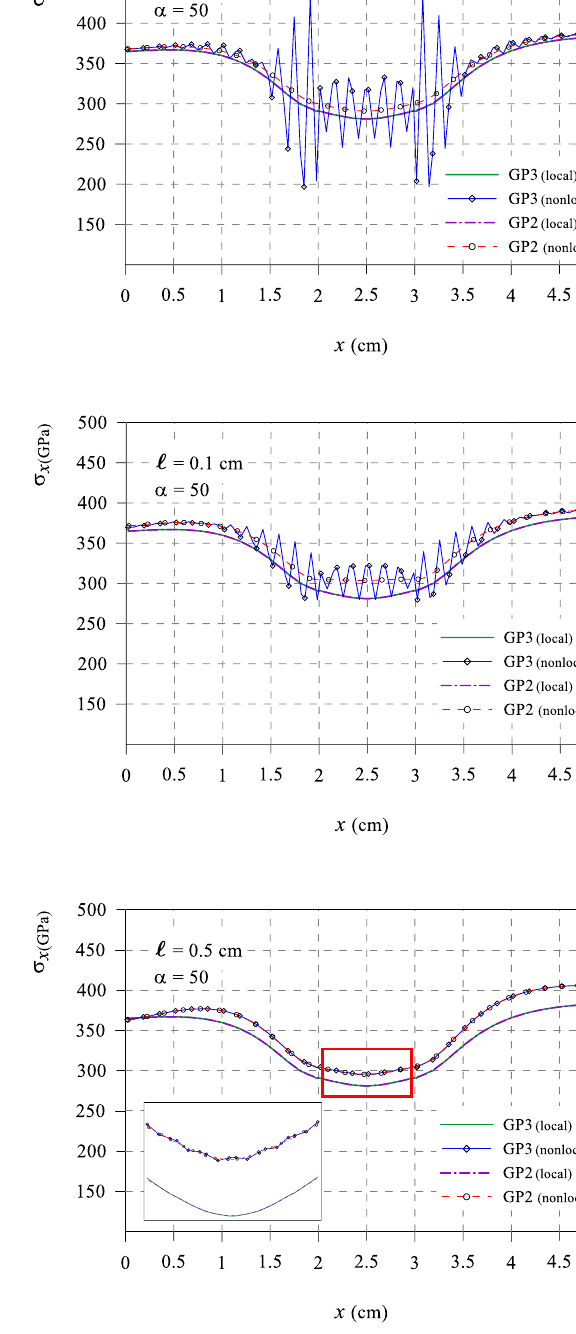
Figure 6: Local and nonlocal strain profiles ε x , obtained with full (GP3 curves) and reduced (GP2 curves) integration for the plate of Figure 5, at the mid section y=2.5a : a ) for ℓ = 0.05 ; b ) for ℓ = 0.1 ; c ) for ℓ = 0.5 .